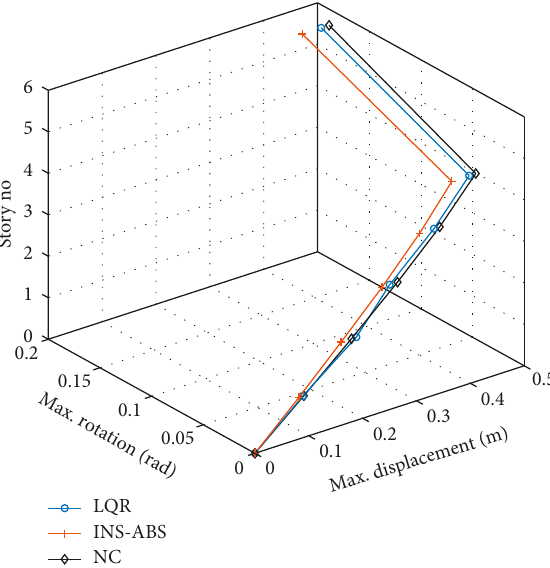
Figure 8: Maximum displacements and rotations for Erzincan bidirectional ground motion.